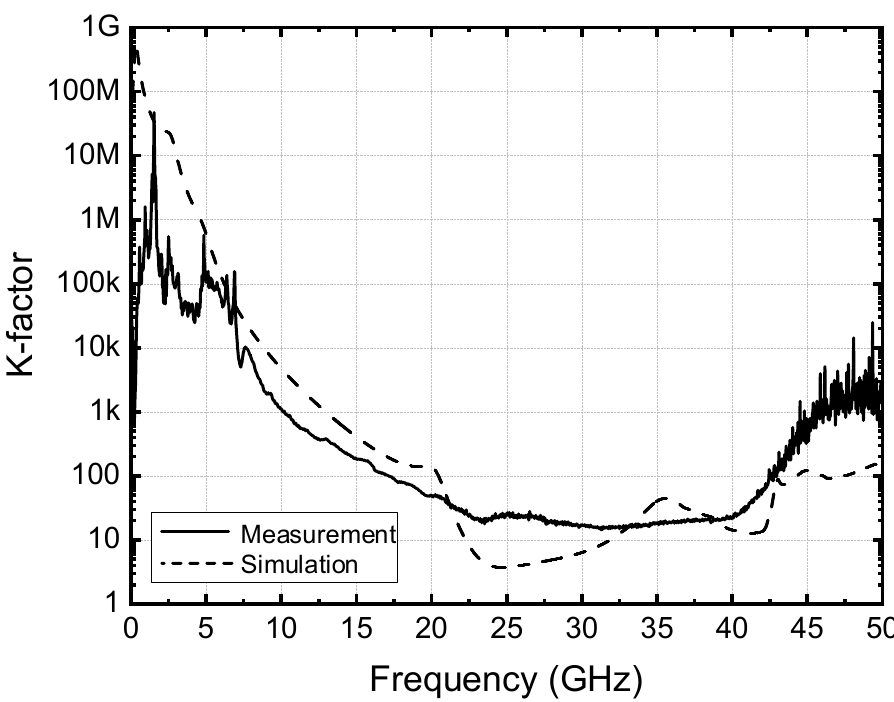
Figure 10. Stability factor based on the measured S-parameters.